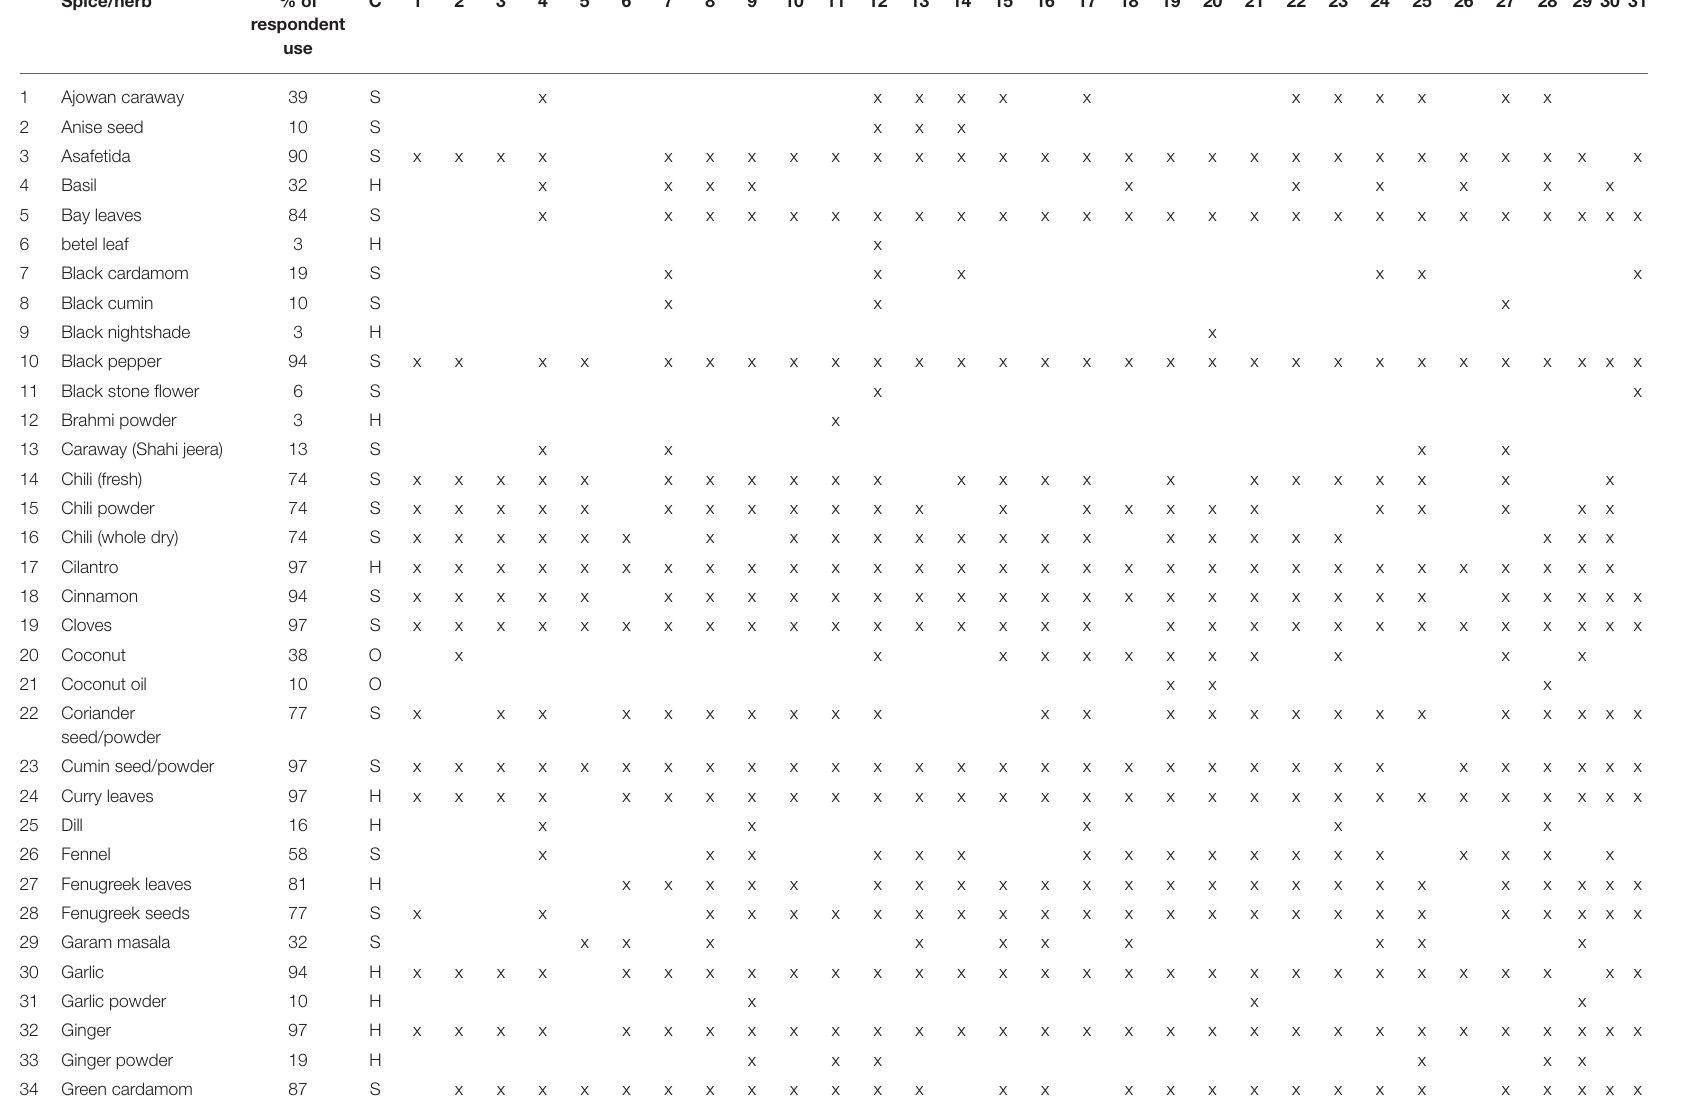
TABLE 2 | All listed spice and herb items from 31 southern California Indian immigrant respondents.